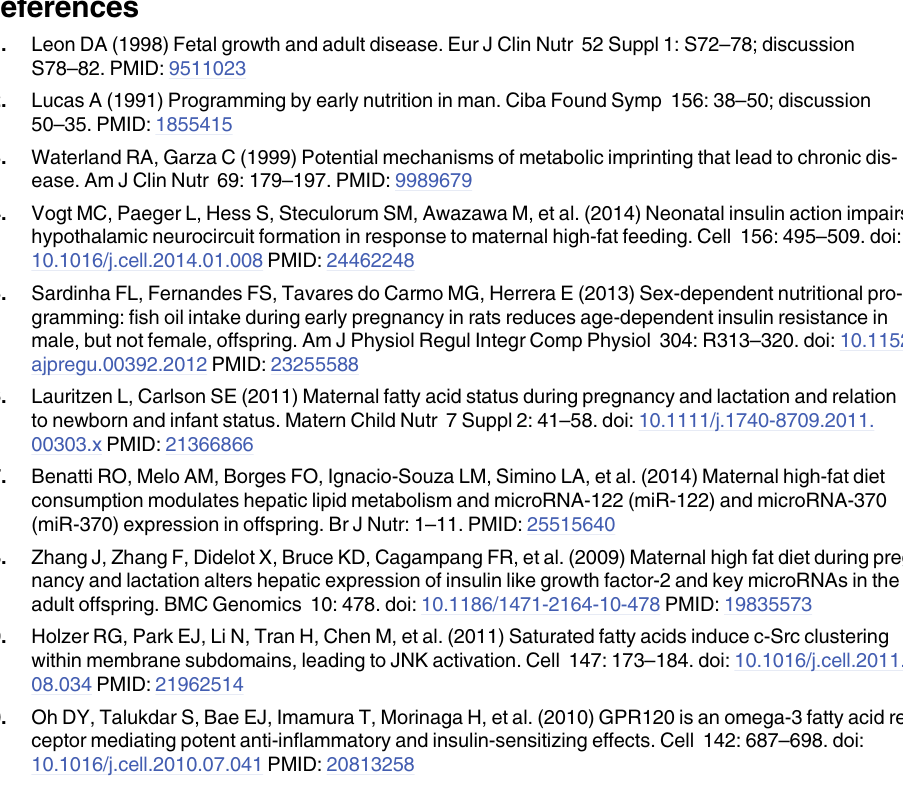
S2 Fig. (A – B) Expression levels selected genes related to insulin signaling in liver of adult pups according to their mother ’ s dietary treatment during the first 12 days of pregnancy. Data is expressed as fold change (mean ±SEM) relative to soybean (SO) diet group. Olive (OO) diet; fish (FO) diet; linseed (LO) diet; or palm-oil (PO) diet. Animals per group n = 5. (TIF) S3 Fig. Maternal fish oil diet during early gestation alters hepatic expression of key miR- NAs related to insulin signaling in the adult offspring. A maternal FO diet during 12 days gestation might regulate different genes related to insulin signaling and their predicted and val- idated targets in the liver tissue of adult offspring. Igf2 and Serpine1 are targets of miR-192/215 and miR-10b family. miR-21 targets Pten, which is involved in liver glucose metabolism and other related process. Other validated targets of miR-21 related to diabetes are the fas ligand (Faslg), Pdcd4 and Tiam1. miR-377 is also related to diabetic nephropathy [35]. miR-26b, which is regulated by glucose levels [47], is required for adipogenesis and target Pten and Adam17 [45,46].